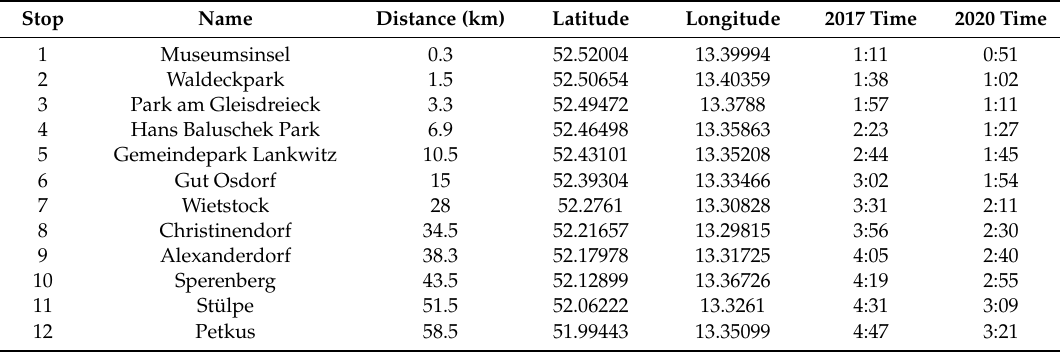
Table A1. Information on the measurement locations, distance to city center and measurement times.